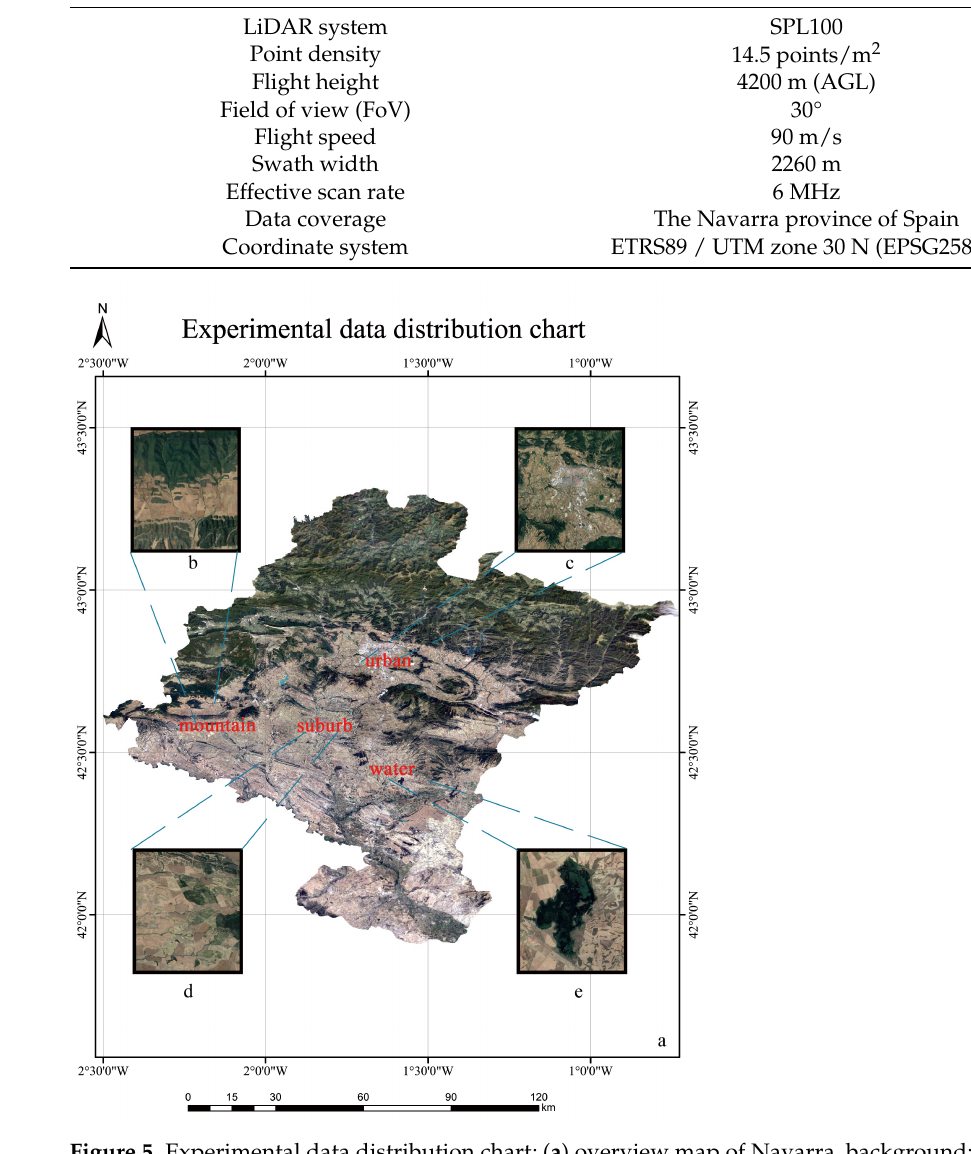
Figure 5. Experimental data distribution chart; ( a ) overview map of Navarra, background: Google Earth; ( b ) the mountain area of Sorlada; ( c ) part of the urban area of Pamplona; ( d ) part of the suburb area of Berbinzana; ( e ) Laguna de Pitillas Lake and its